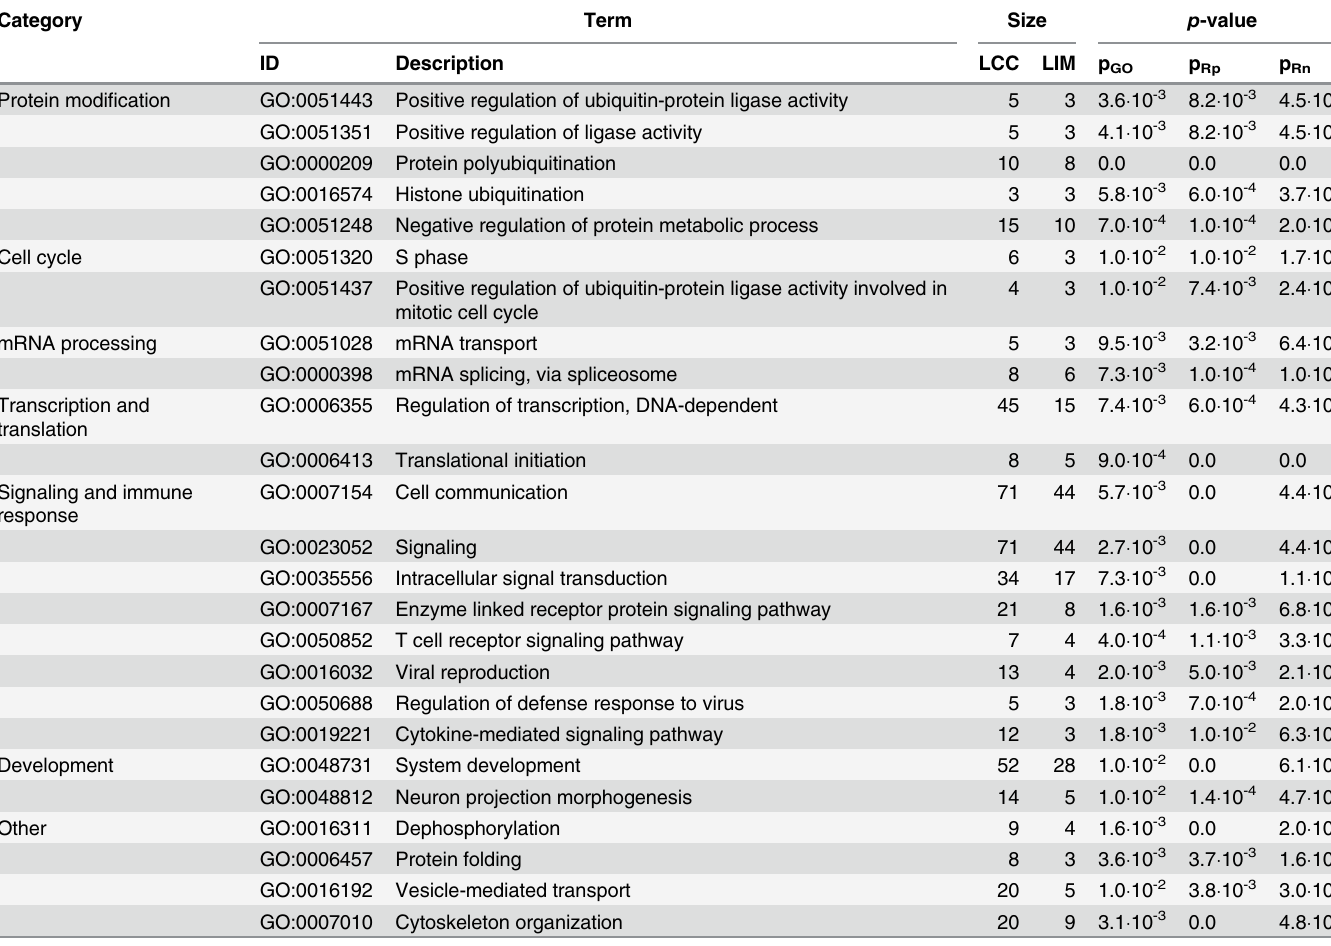
Table 4. Enrichment of Gene Ontology (GO) biological processes in host subnetworks. LCC represents the number of proteins in the largest connected component annotated with a given term; LIM represents the number of proteins in the largest interaction module for a given term; p GO denotes the probability of the same number of proteins as the LCC being annotated with a given GO term solely through a random selection; p Rp denotes the probability that a given number of proteins as the LIM are annotated with a given GO term solely through random selection; p Rn represents the probability that a given number of proteins as the LIM are annotated with a given GO term solely through random selection in a random network that has the same degree distribution as our human network. All p -values were assessed using the Benjamini-Hochberg method to meet a maximum false discovery rate threshold of 5% [45]. The table contains only the lowest-level GO terms; the complete data are available in S1